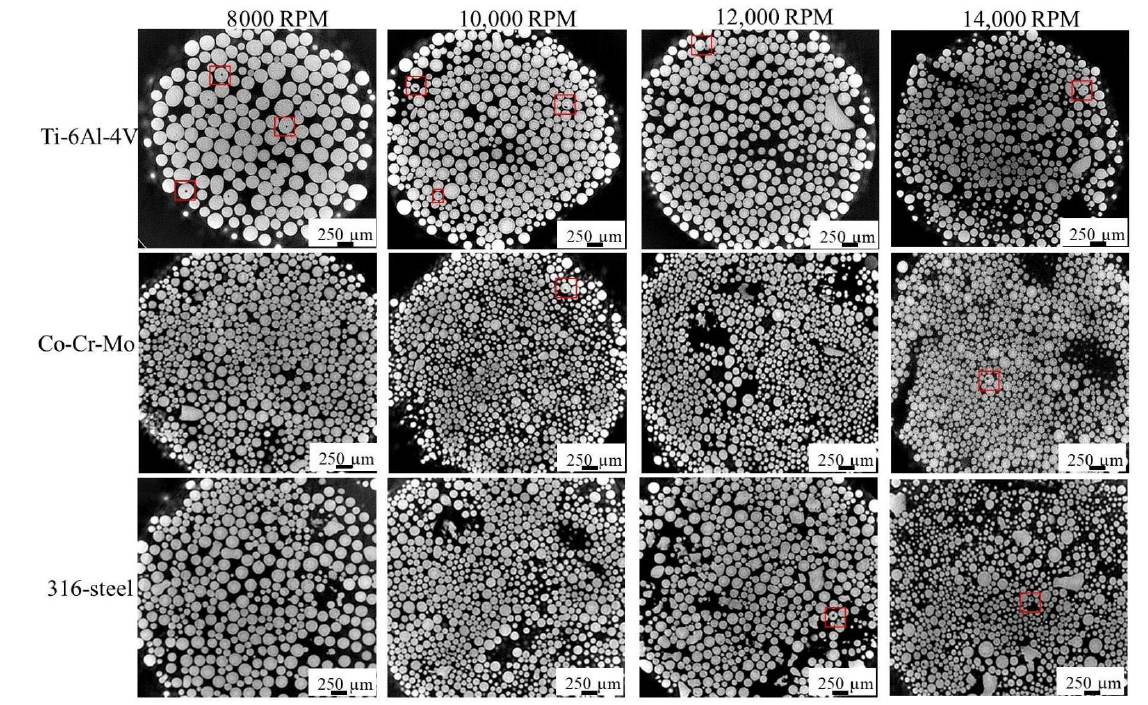
Figure 4. Synchrotron X-ray CT cross-sectional morphology of 3 alloy powders by at various rotation speeds [25].